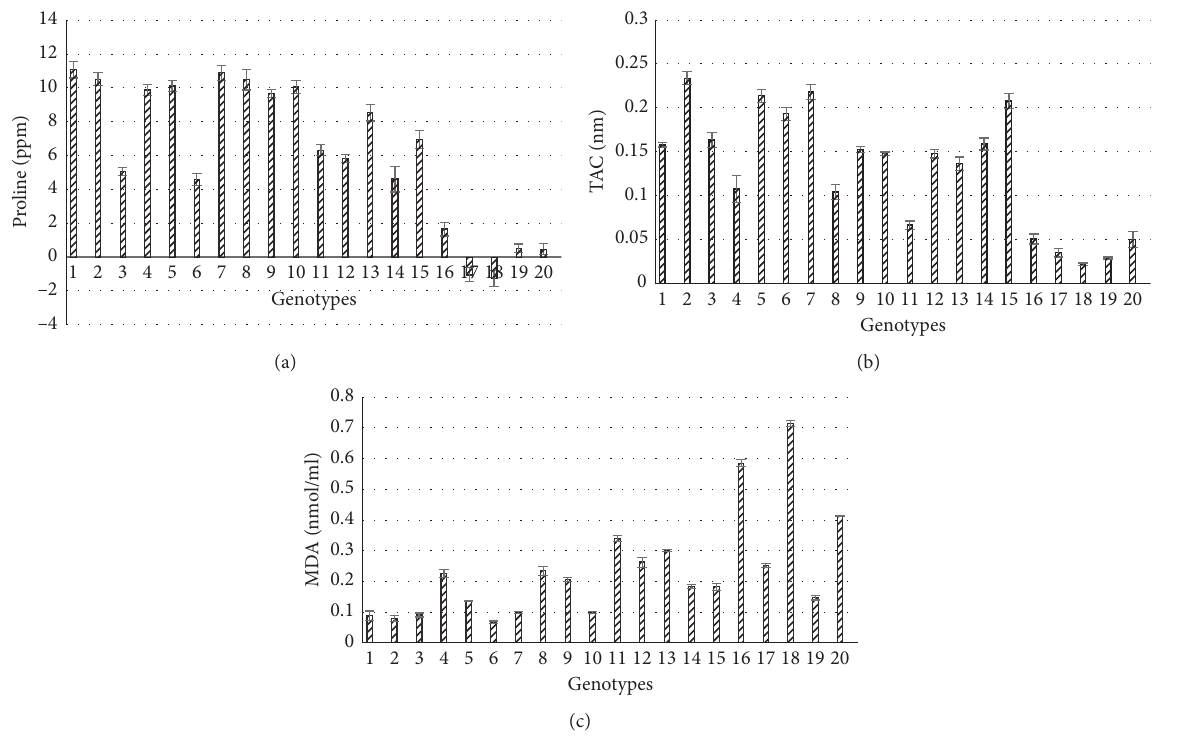
Figure 3: Drought-induced change in the production of biochemical. (a) Variation in the production of proline. (b) Increase in total antioxidant capacity (TAC). (c) Increase in the formation of malondialdehydes (MDA). On the horizontal line, 1–20 numbers show the rice genotypes. 1–10 are drought tolerant, 11–15 are moderately drought tolerant, and 16–20 are drought